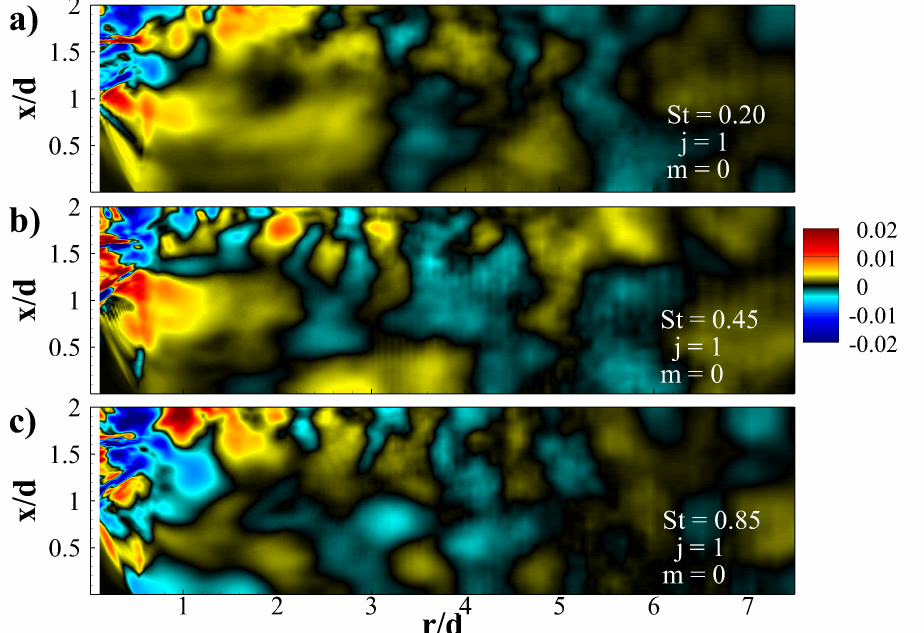
Figure 11. Pressure field of the first SPOD mode of the axisymmetric azimuthal mode for different Strouhal numbers of ( a ) St = 0.20; ( b ) 0.45; and ( c )